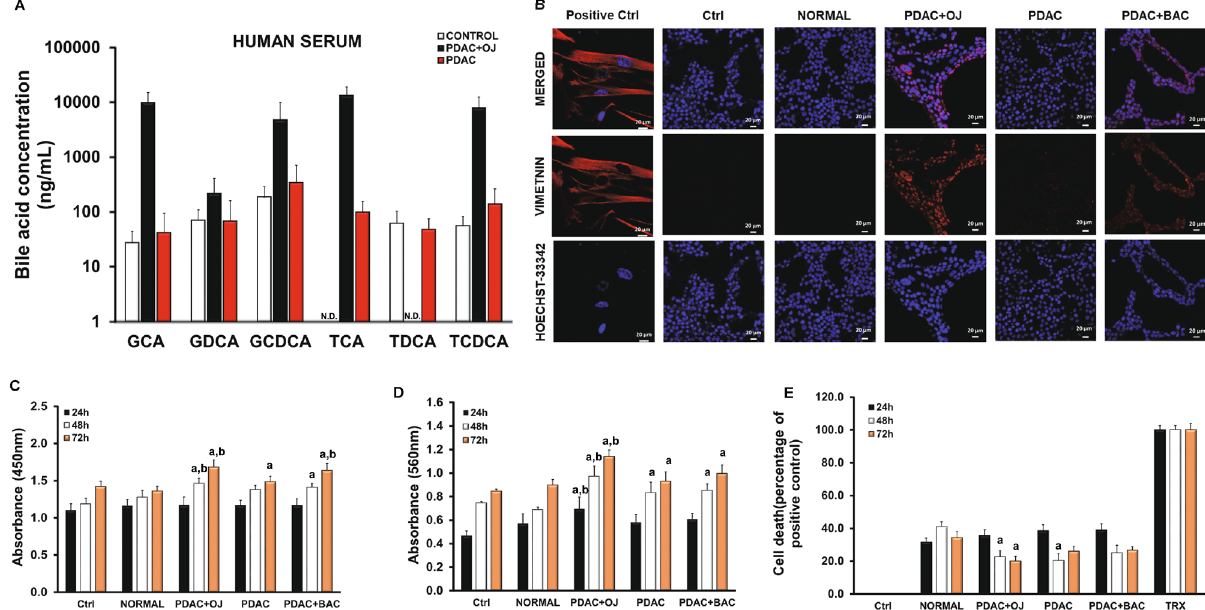
Figure 1. Serum levels of bile acids in pancreatic cancer patients and the effect of serum on Capan-1 cells. ( A ) Serum levels of bile acids (BAs) in healthy volunteers and pancreatic ductal adenocarcinoma patients (PDAC) with or without obstructive jaundice (OJ) were measured by LC–MS. GCA glycocholic acid, TCA taurocholic acid, GDCA glycodeoxycholic acid, TDCA taurodeoxycholic acid, GCDCA glycochenodeoxycholic acid, TCDCA taurochenodeoxycholic acid. N.D. not detected. ( B ) Capan-1 cells were treated with human serum obtained from healthy volunteers and PDAC patients and the expression of vimentin was investigated by immunocytochemistry. Control (Ctrl) samples were treated with culture medium only. As a positive control gastric myofibroblasts were used. The rate of proliferation ( C ), adhesion ( D ) and viability ( E ) was measured in Capan-1 cells. a = p ≤ 0.05 vs. Control, b = p ≤ 0.05 vs. PDAC. BAC bile acid cocktail, TRX